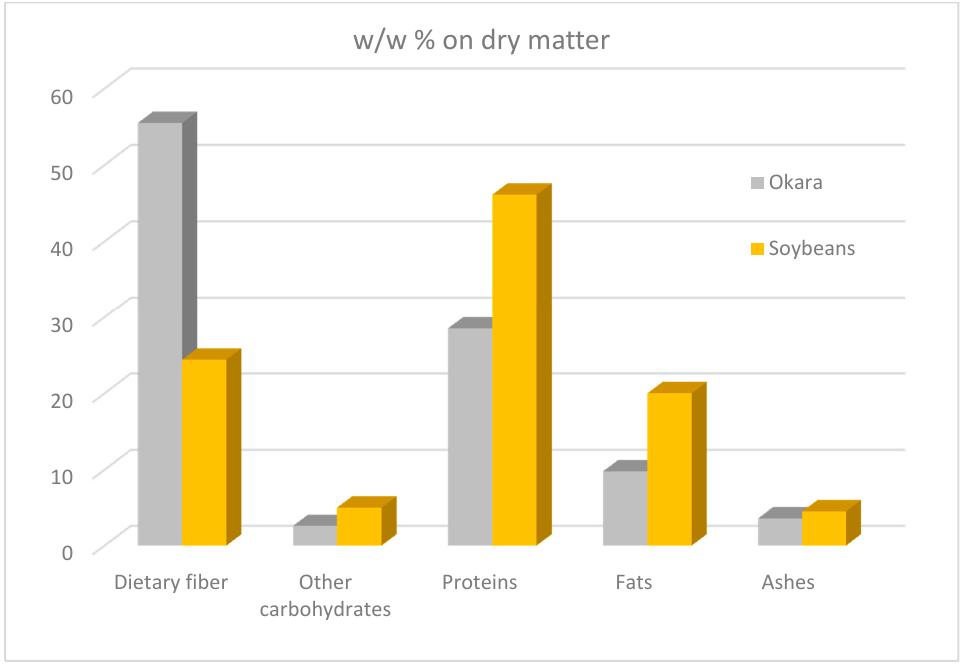
Figure 3. Dry composition of okara, compared to SBs.